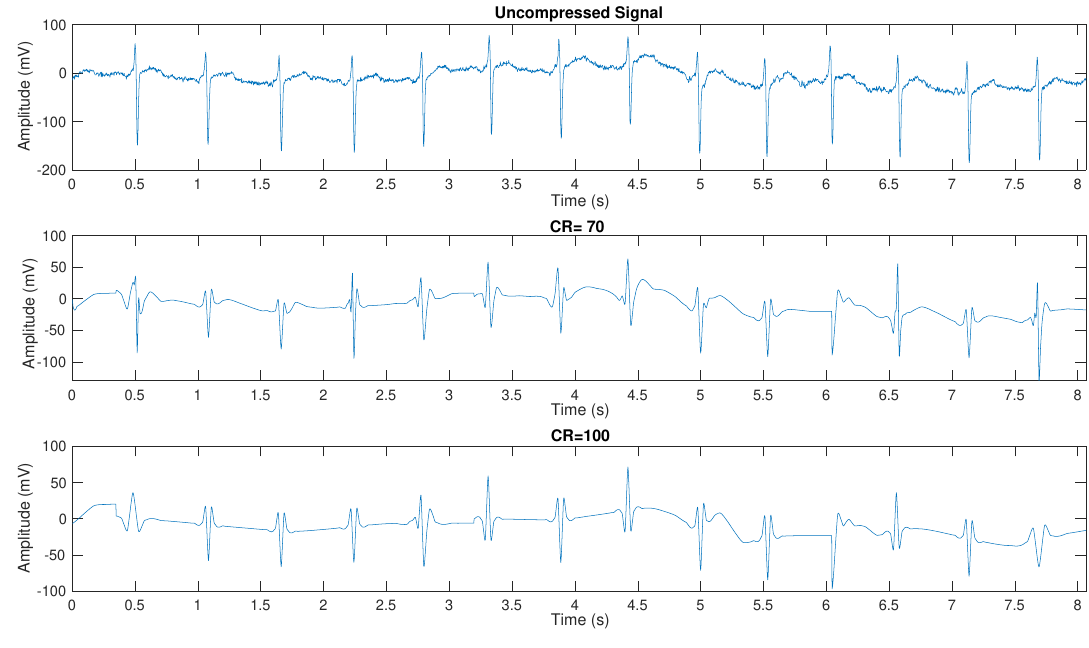
Figure 3. Original ECG signal from first 8 s of record 04126. Top plot: uncompressed signal. Middle : reconstructed signal with CR = 70. Bottom : reconstructed signal with CR =